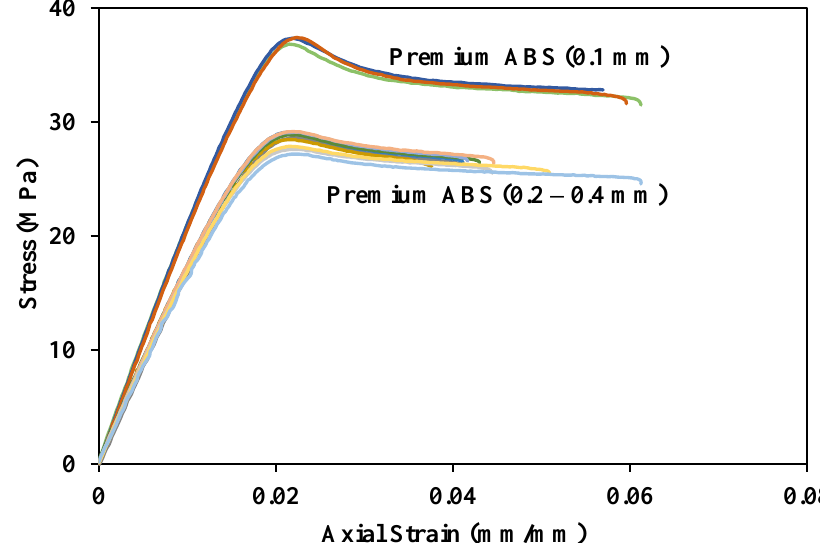
Figure 16. Tensile response of Premium ABS at all print layer heights.